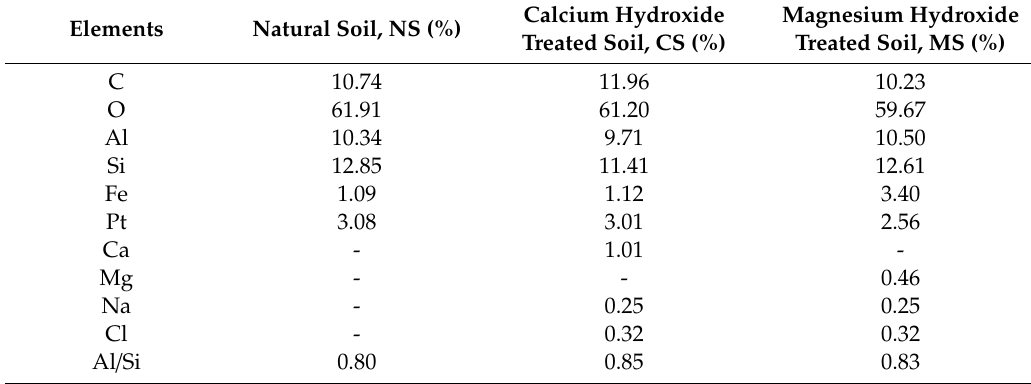
Table 4. Elemental compositions of treated and untreated soils after 14 days curing